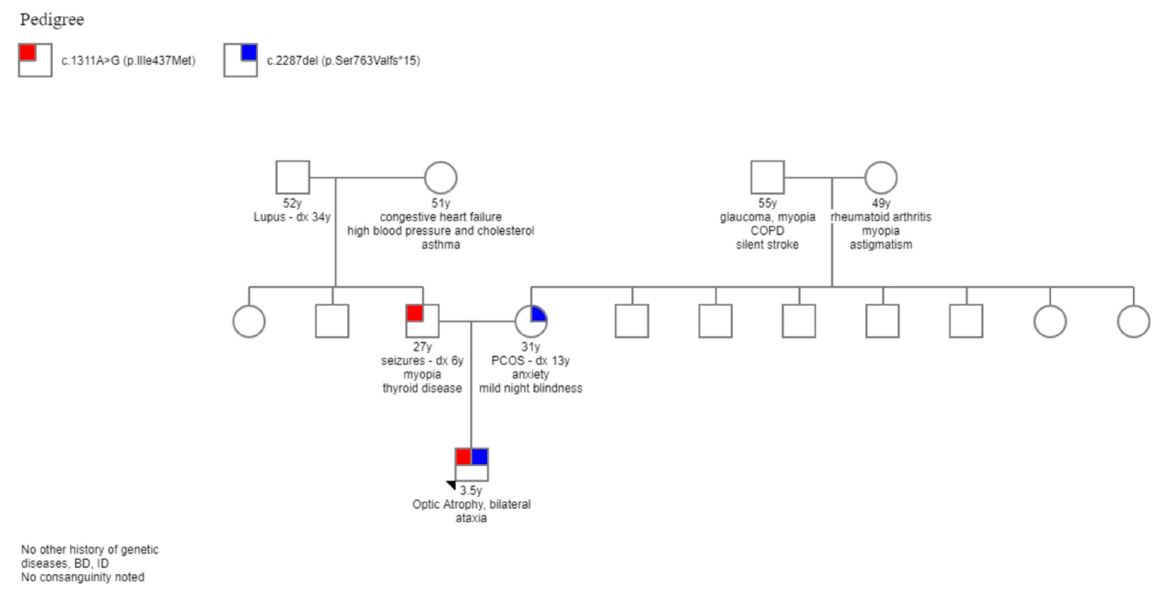
Figure 8. Complete family pedigree. Red colored is the paternally inherited variant and blue color is the maternally inherited variant